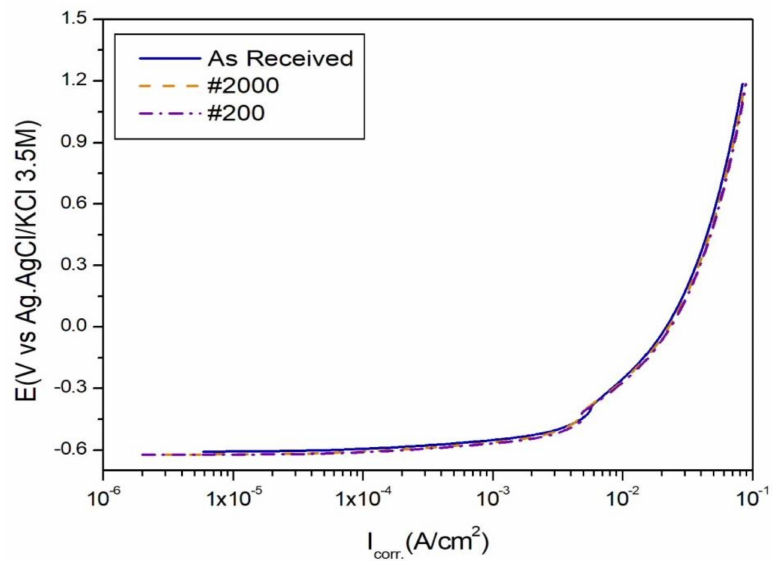
Figure 3. Corrosion current density of SPCC during potentiodynamic corrosion testing with a 5.0 wt.% NaCl aqueous solution